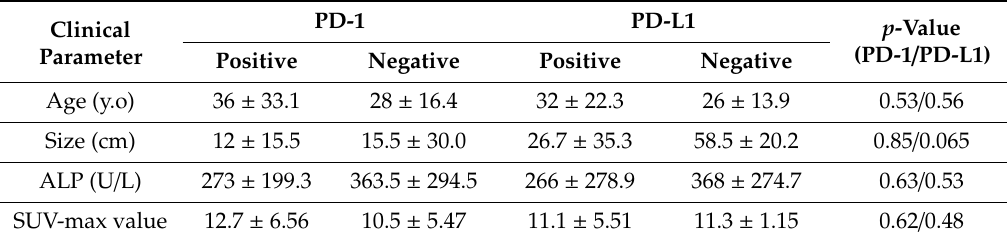
Table 2. Comparison of age, tumor size, and ALP between the PD-1-positive and -negative groups and between the PD-L1-positive and -negative group.